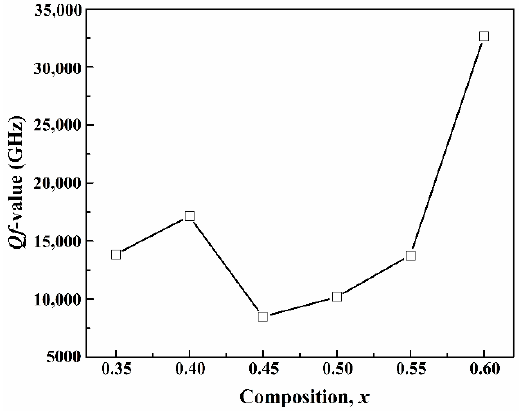
Figure 7. The Qf value of the (1– x )CLT- x NMT ceramics.